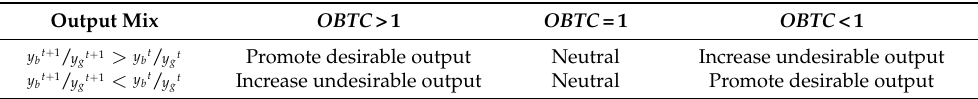
Table 1. Biased technical change direction in output